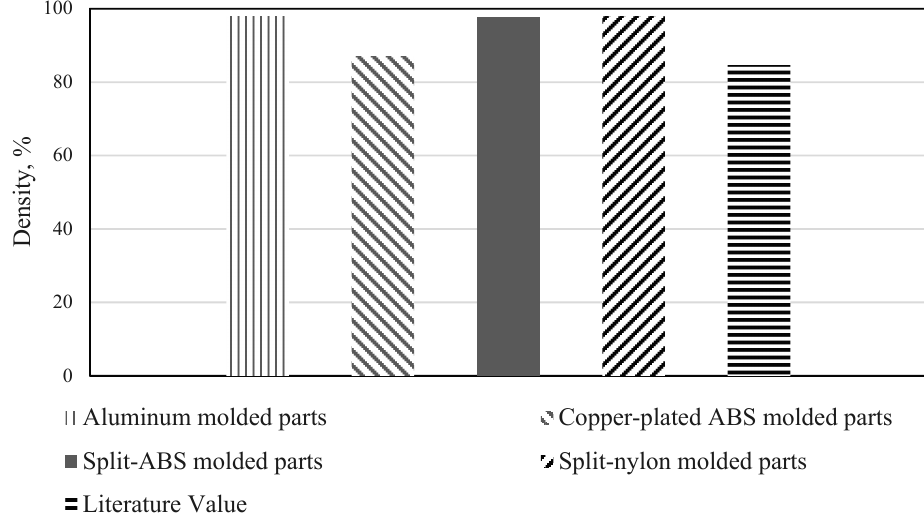
Figure 15. Comparison of densities testing results for sintered parts.